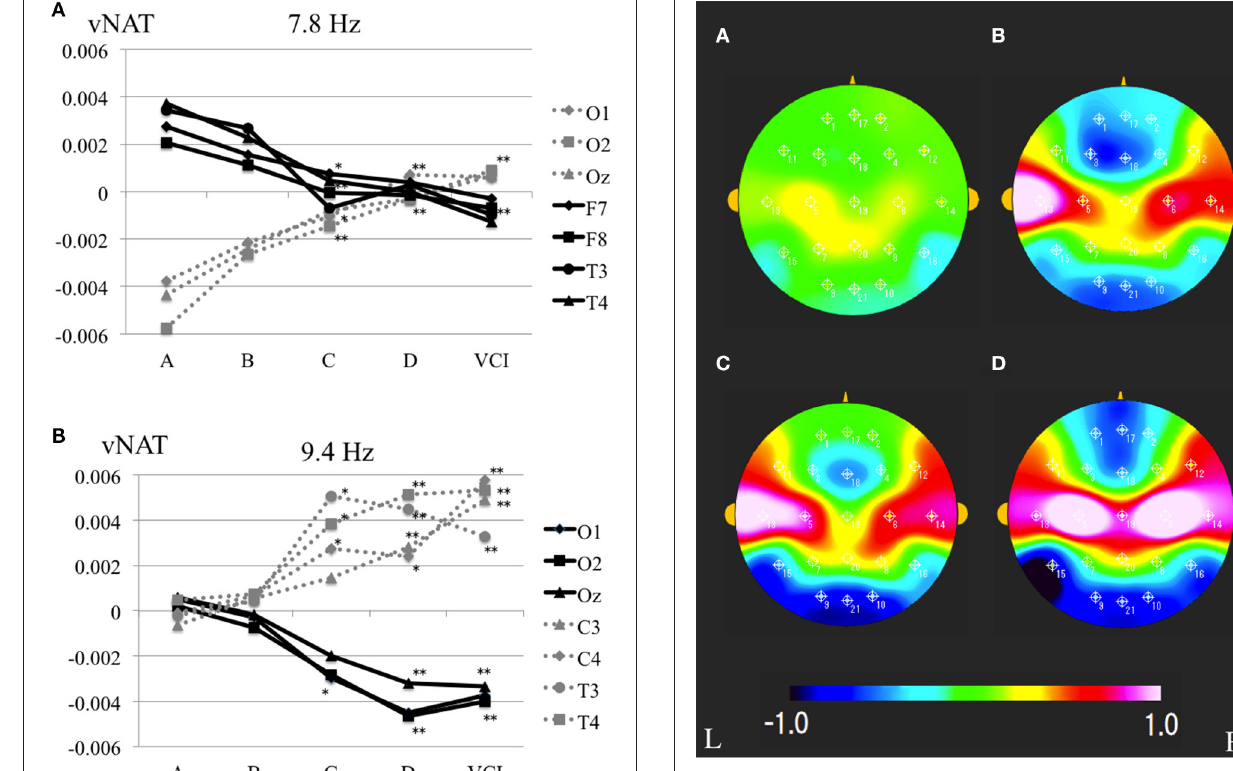
FIGURE 4 | (A) Mean vNAT plot at 7.8 Hz frequency range over occipital areas (O1, O2, Oz) and fronto-temporal areas (F7, F8, T3, T4) for group A, group B, group C, group D, VCI group, respectively. (B) Mean vNAT plot at 9.3 Hz frequency range over occipital areas (O1, O2, Oz) and centro-temporal areas (C3, C4, T3, T4) for group A, group B, group C, group D, VCI group, respectively. * P < 0.05, ** P < 0.01 (Dunnett ’s test as control group A).